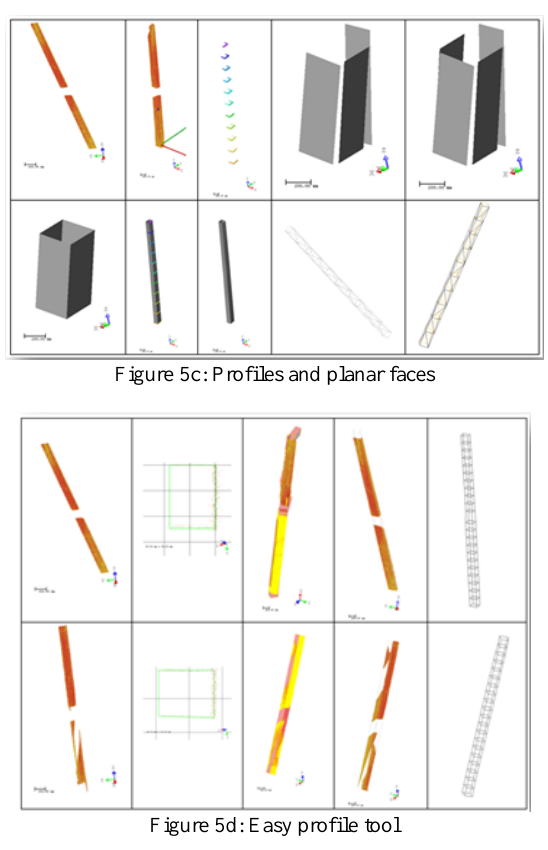
Figure 5d: Easy profile tool